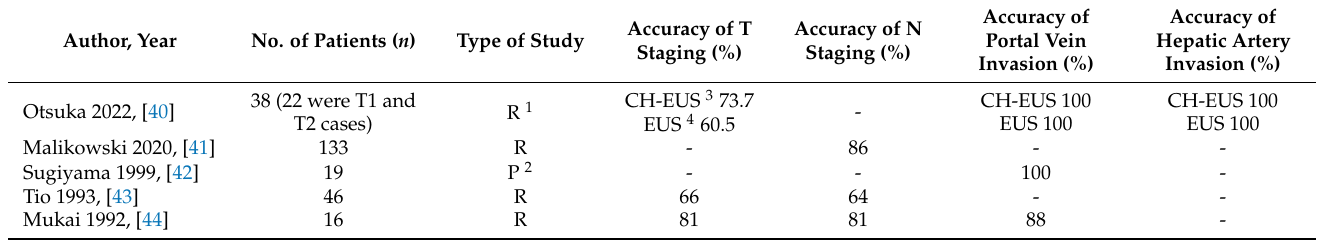
Table 1. Accuracy of endoscopic ultrasound staging in extrahepatic